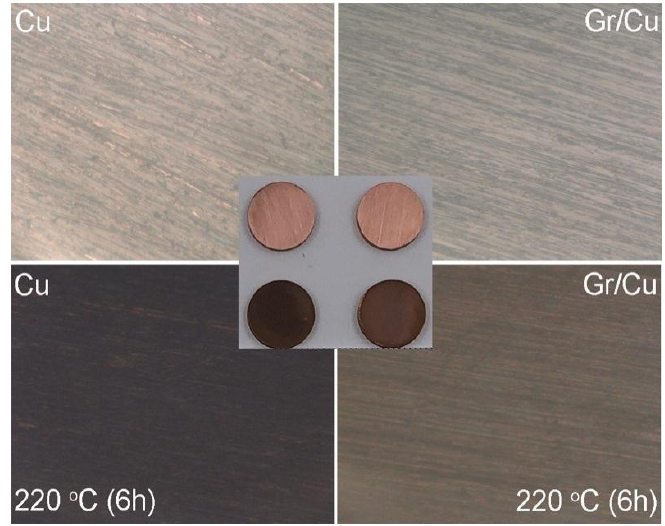
Figure 2. Photographs and OM images of Cu counterpart and Gr/Cu composites before and after thermal oxidation.